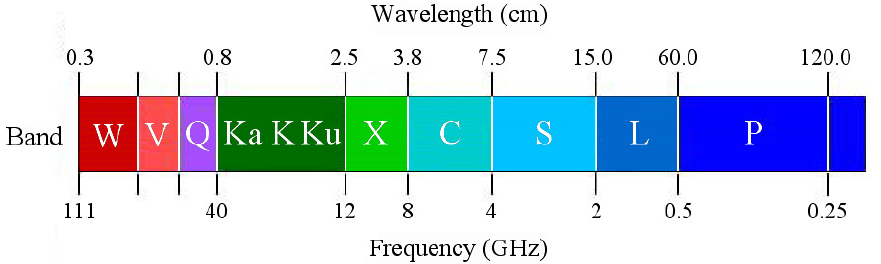
Figure 1. Band designation of microwave spectrum used for SAR.